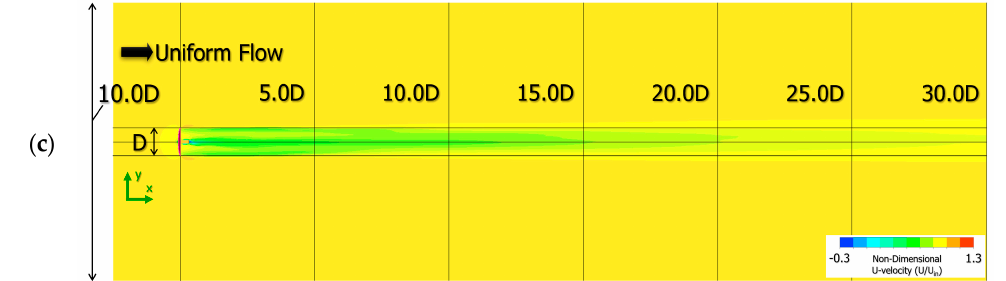
Figure A3. Spatial distribution of U-velocity for the time-averaged flow field in the x–y plane (top view) at hub height of the wind-turbine: ( a ) 32.5 D (x) × 5.0 D (y) × 3.5 D (z), ( b ) 32.5 D (x) × 5.0 D (y) × 10.0 D (z), and ( c ) 32.5 D (x) × 10.0 D (y) × 10. 0 D (z).